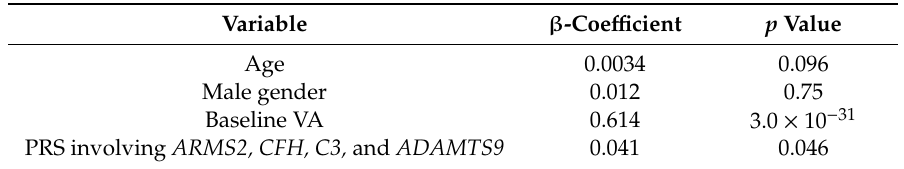
Table 3. Baseline factors influencing logarithm minimum angle resolution (logMAR) BCVA at 12 months (multiple regression